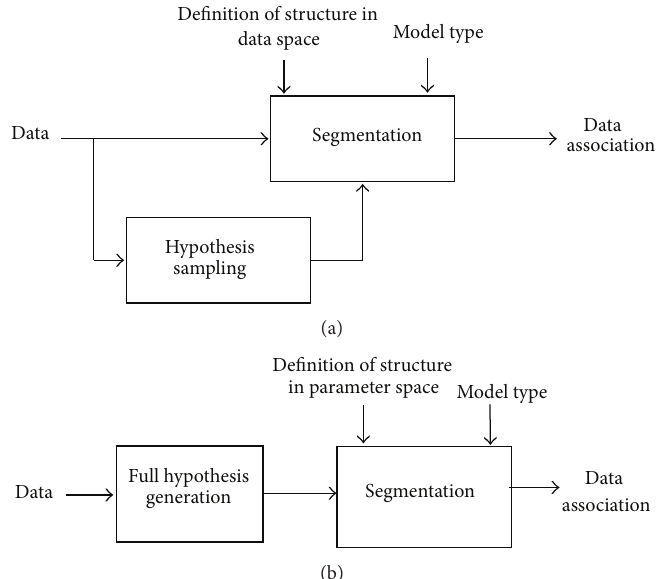
Figure 6: (a) The block diagram of a typical parametric segmentation solution. (b) The block diagram for the proposed analysis of the segmentation problem.